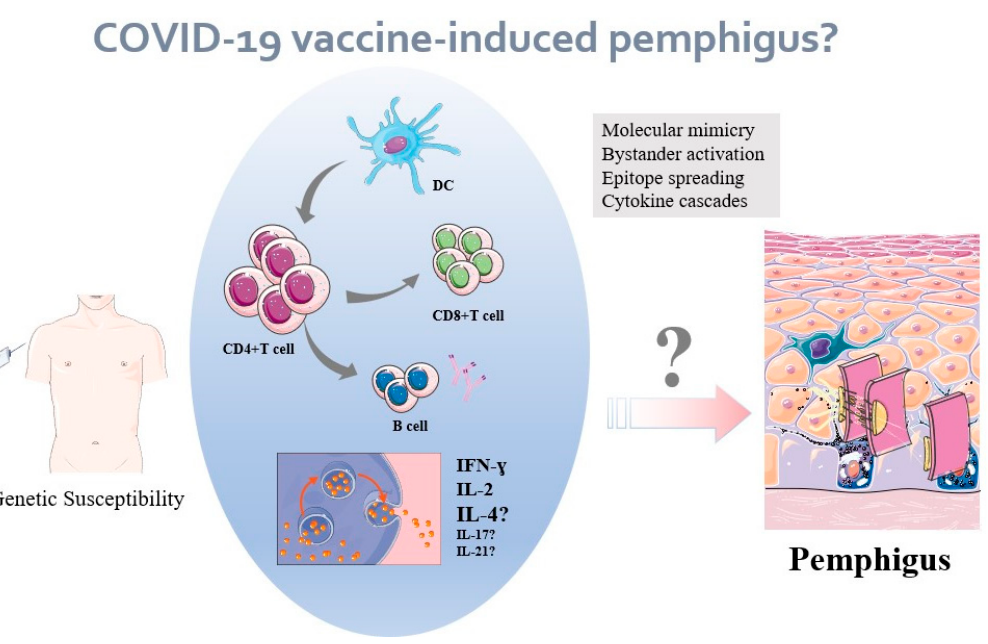
Figure 1. An unproven hypothesis: mechanisms of COVID-19 vaccine-induced pemphigus? It is hypothesized that vaccination against COVID-19 could trigger an immunological response in genetically predisposed individuals. The vaccine-related autoimmune responses may include molecular mimicry, bystander activation, and epitope spreading, etc. The similar components of human protein promote dendritic cell maturation and elicit robust T and B cell responses, thereby subsequently activating bystander autoreactive lymphocytes and episode spreading, along with large amounts of cytokines, concurrently contributing to the autoimmune inflammation in pemphigus patients.